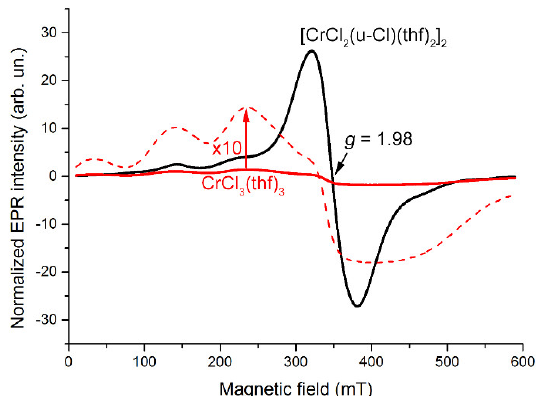
Figure 4. EPR spectra of [CrCl 2 (μ-Cl)(thf) 2 ] 2 and the commercial CrCl 3 (thf) 3 .